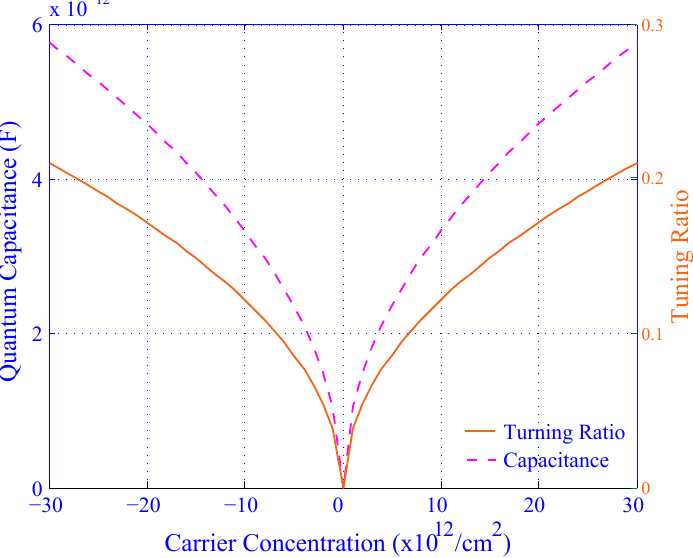
Figure 8. The effect of carrier concentration on the quantum capacitance and tuning ratio for silicene. The resonant frequency depends on the quantum capacitance and the